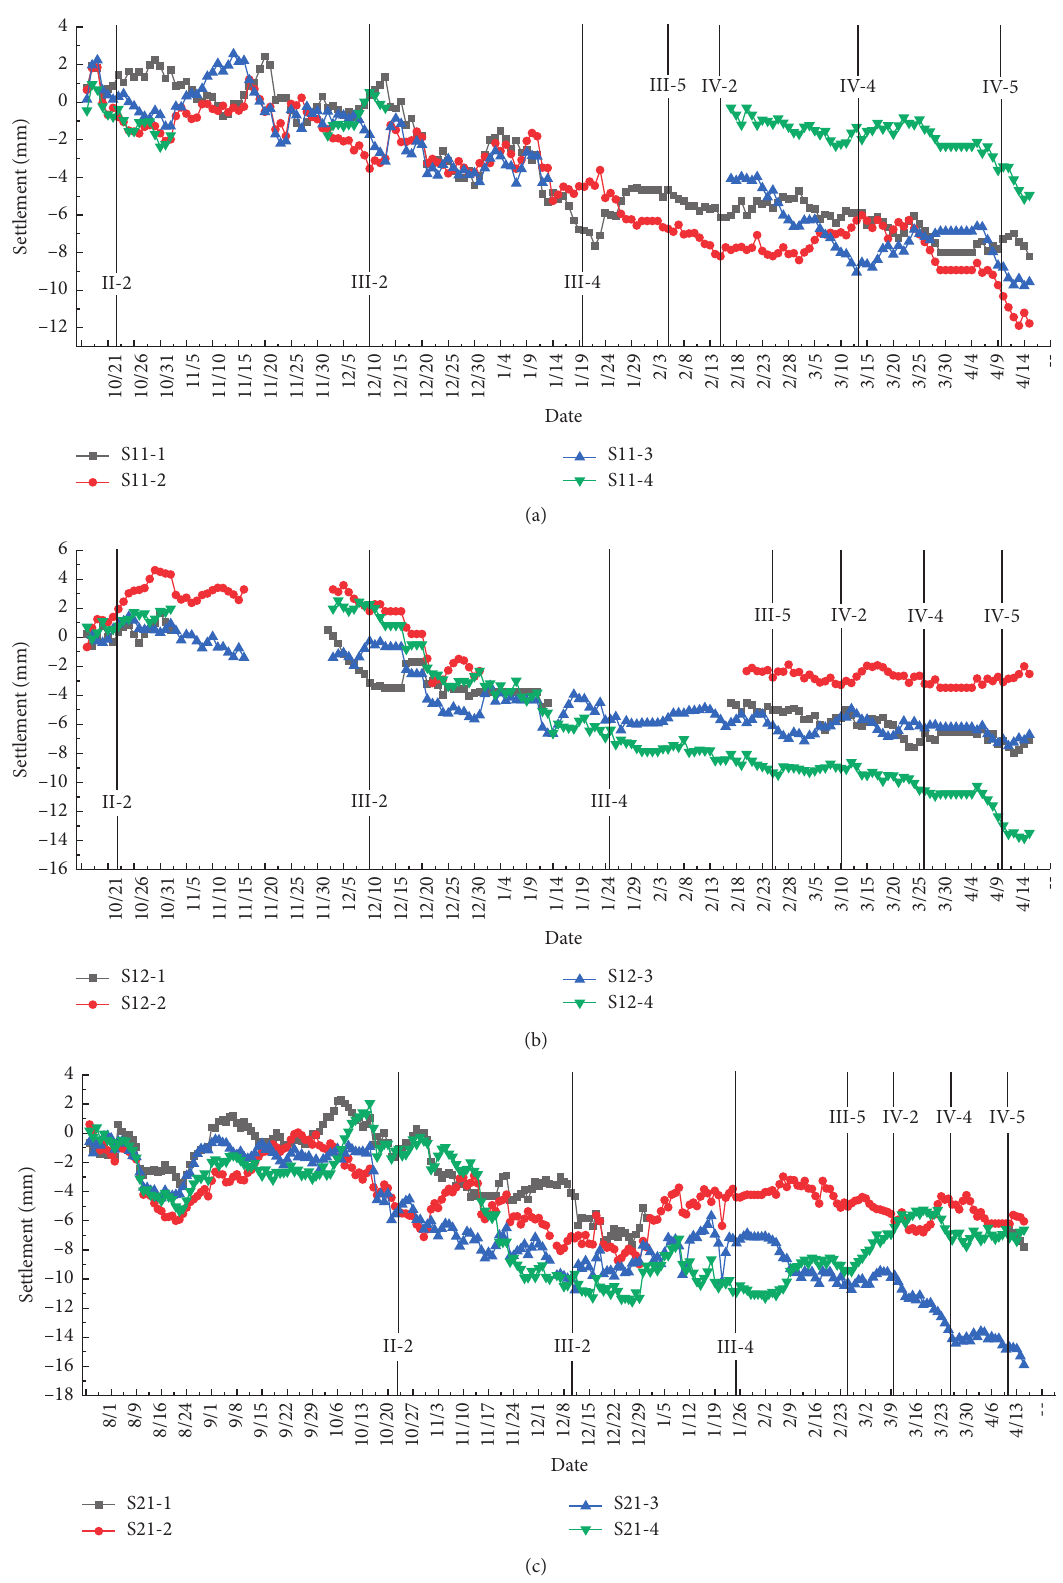
Figure 7: Monitoring results of the ground settlement at (a) S11, (b) S12, and (c) S21 during the PIP